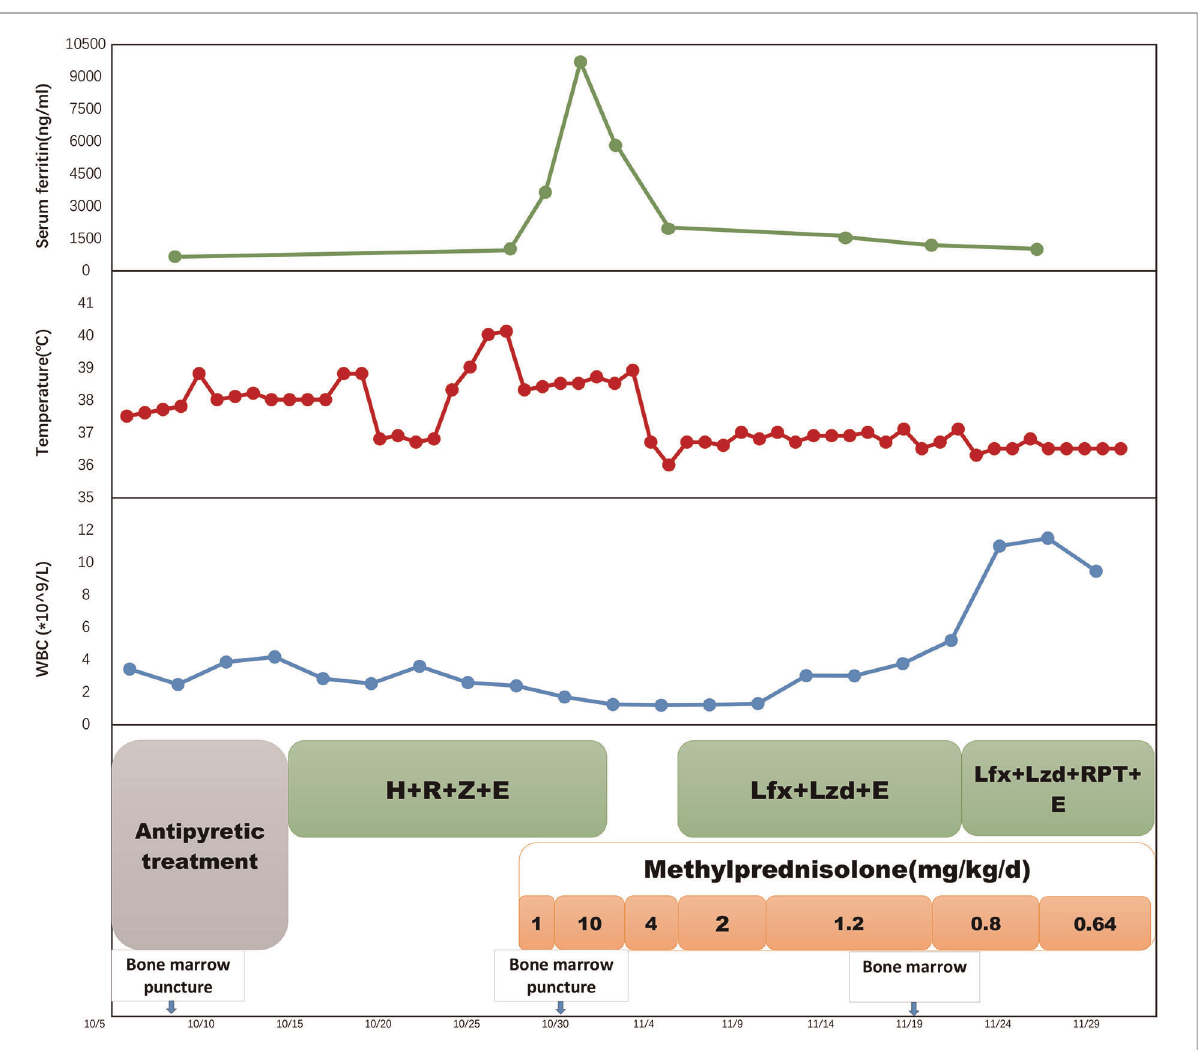
FIGURE 3 A timeline of treatment and clinical events with laboratory parameters. H, isoniazid; R, rifampicin; Z, pyrazinamide; E, ethambutol; Lzd, linezolid; Lfx, levo fl oxacin. RPT,